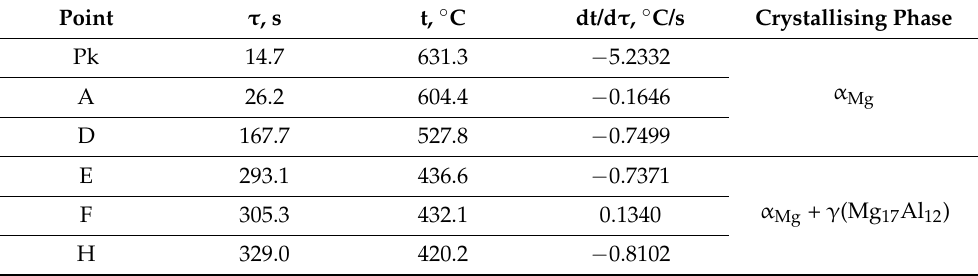
Figure 1. DTA characteristics of alloy AZ91 ( a ) and AZ91 with 0.3 wt % of Zr ( b ) during solidification in a ceramic DTA sampler. Table 3. Characteristic DTA points of AZ91 magnesium alloy.